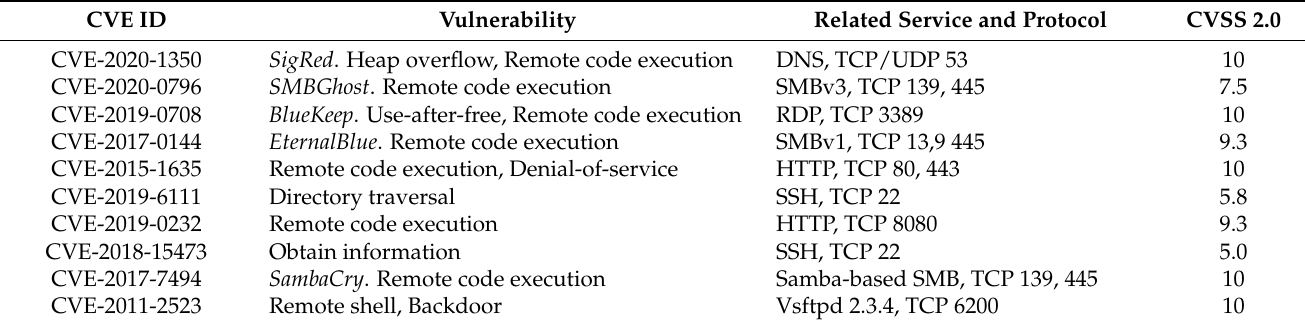
Table 4. CVE-based vulnerability table for disinformation and intended leakage with HS-Decoy. CVE